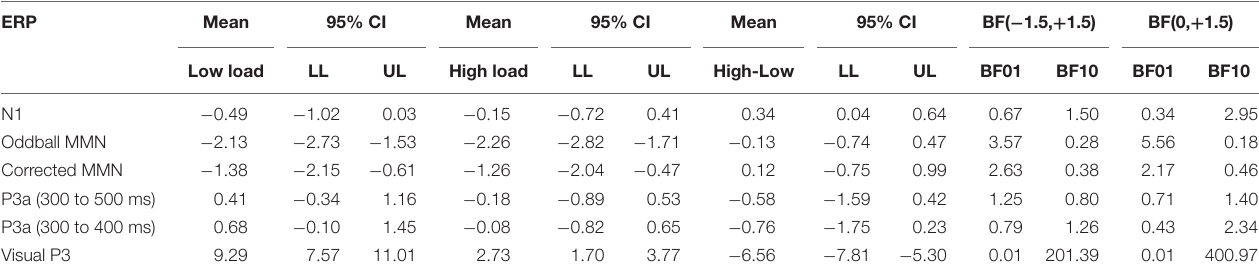
TABLE 1 | Descriptive and inferential statistics for mean ERP